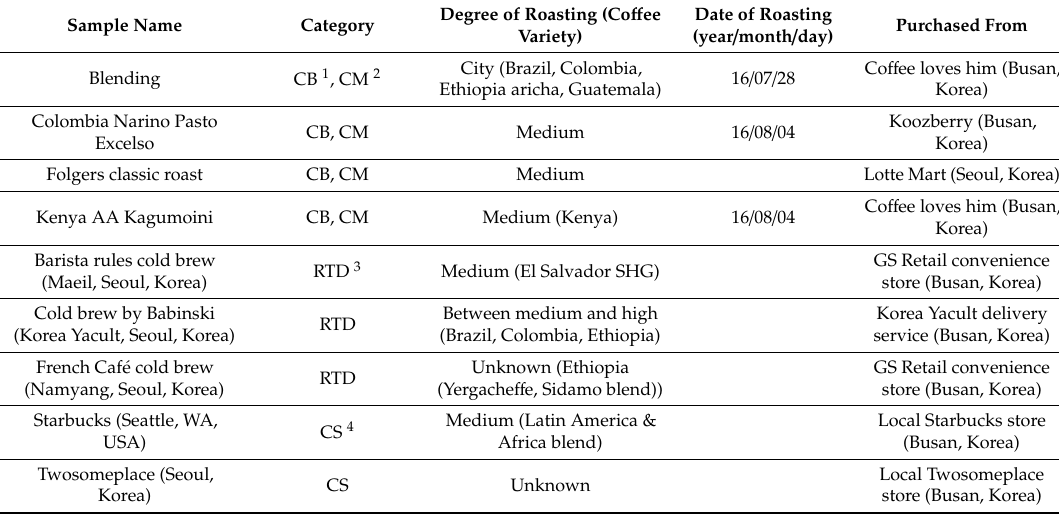
Table 1. Co ff ee samples